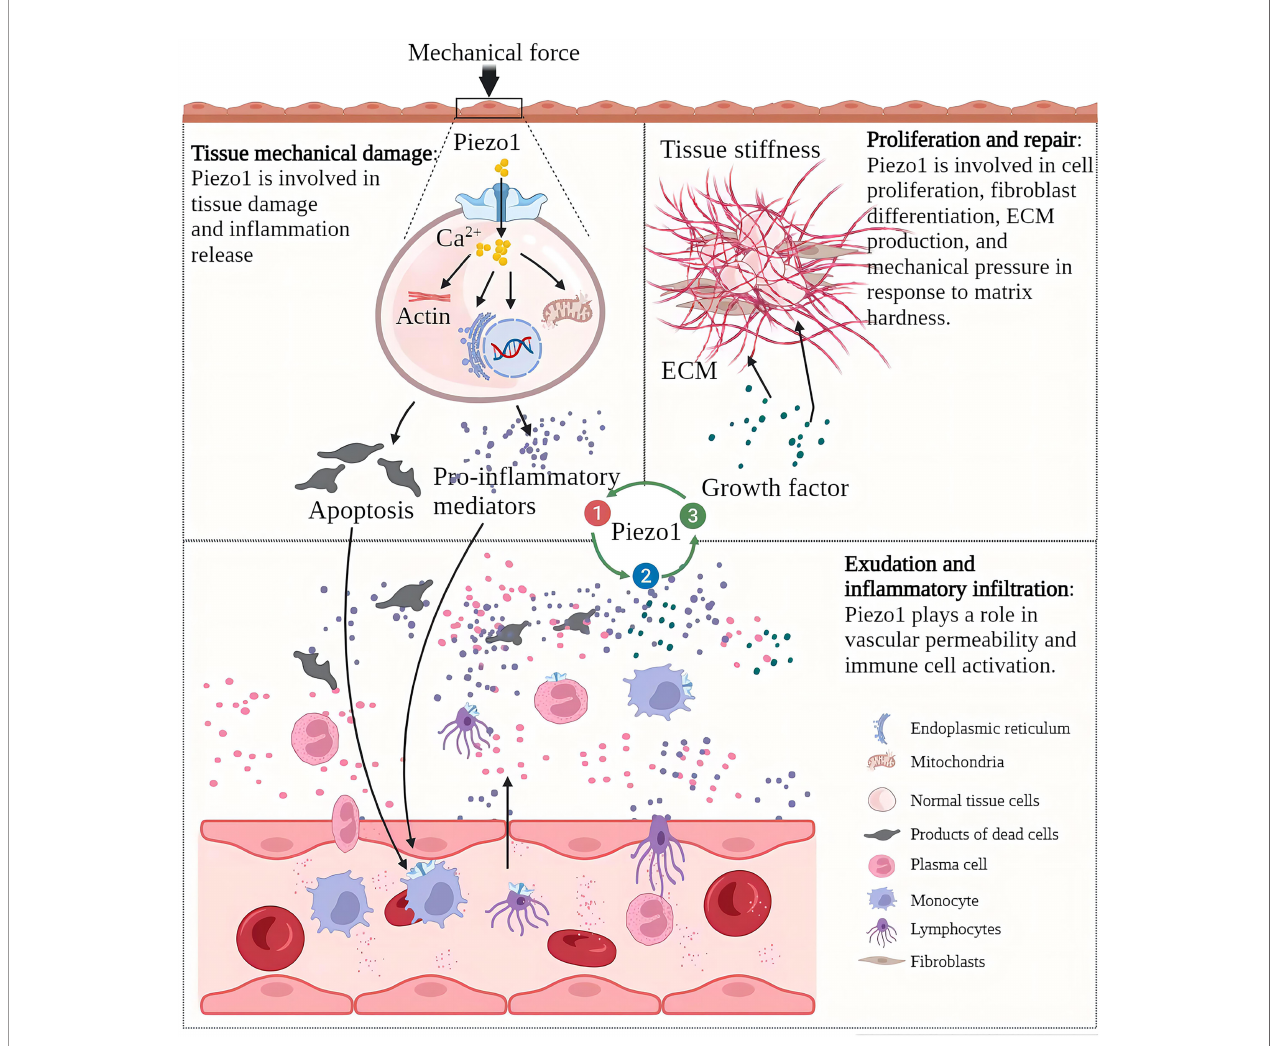
FIGURE 2 | Piezo1 is involved in various pathological chronic in fl ammation processes and acts as a sensor and effector of mechanical stress within tissues in in fl ammation. Chronic in fl ammation is characterized by tissue injury, in fl ammatory in fi ltration, and proliferative repair. The Piezo1 channel transduces mechanical forces into intracellular in fl ammatory signals to induce injury and in fl ammation, and the development of in fl ammation alters the mechanical properties of tissues. Piezo1 senses changes in mechanical stress in the local environment and regulates the progression of chronic in fl